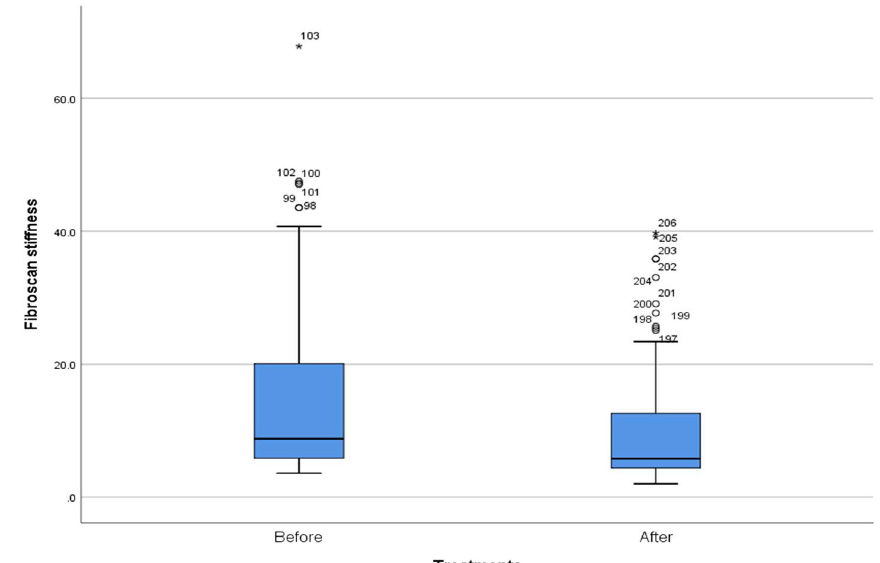
Fig. 4 The liver stiffness Boxplot between before‑ and after‑treatment in patients within > 15 KPa